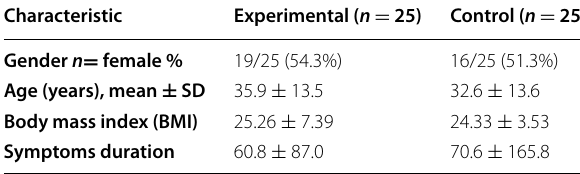
Table 1 Mean (SD) for the participants’ demographic data